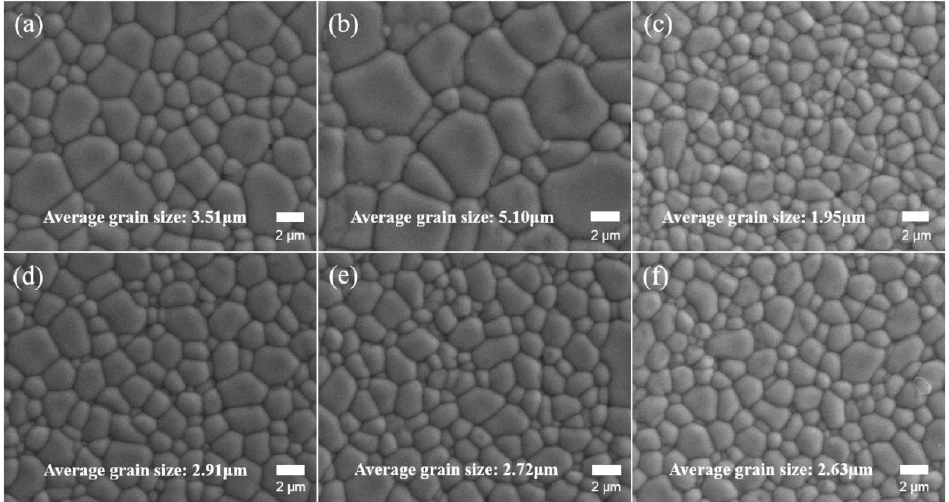
Figure 39. The microstructure of RENbO 4 ceramics sintered at 1600 °C for 10 h: ( a ) NdNbO 4 ( b ) SmNbO 4 ( c ) GdNbO 4 ( d ) DyNbO 4 ( e ) ErNbO 4 ( f ) YbNbO 4 [196] .